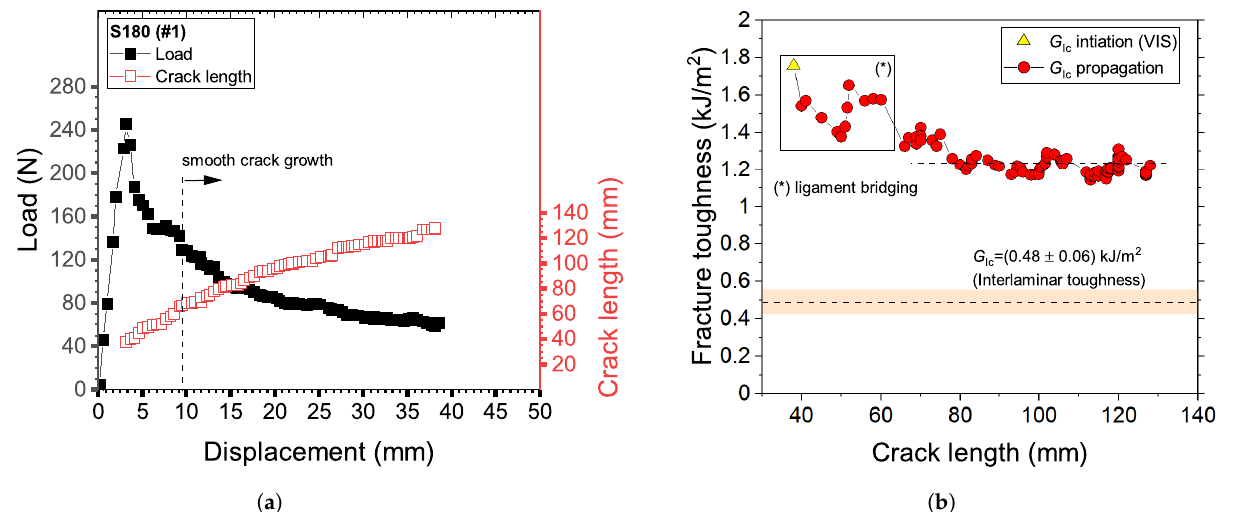
Figure 11. Typical results of DCB samples S180 (sample #1). ( a ) Load-displacement and crack length displacement curves; ( b )